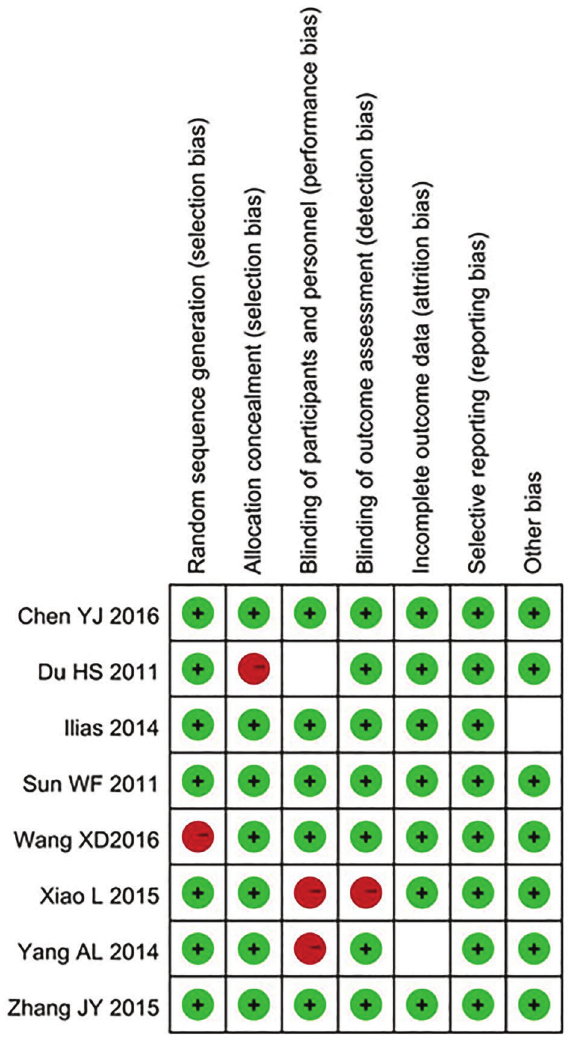
Figure 2. Quality assessment of the included studies. Green: low risk of bias; Blank: unclear risk of bias; Red: high risk of